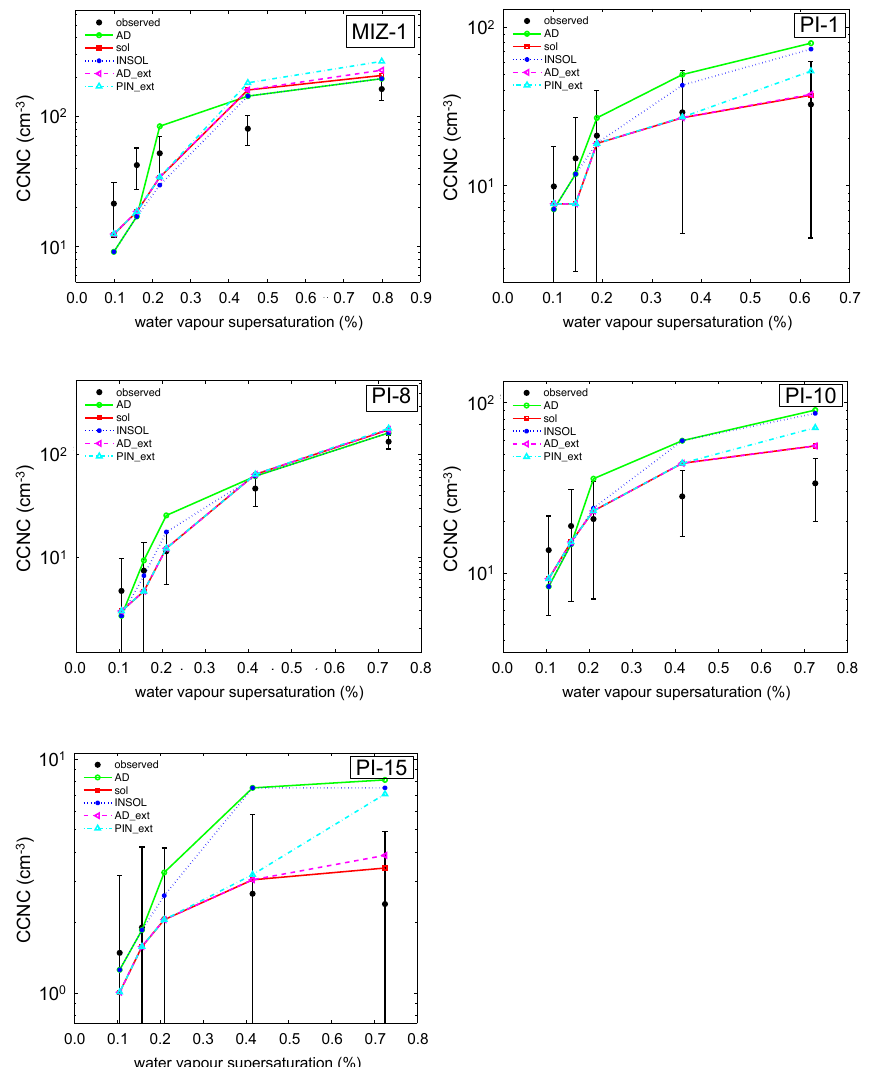
Figure 11. Observed and simulated CCNC for sample MIZ-1, PI-1, PI-8, PI-10 and PI-15, ranging from 0.1% to 0.8% water vapour SS. Error bars represent 1 standard